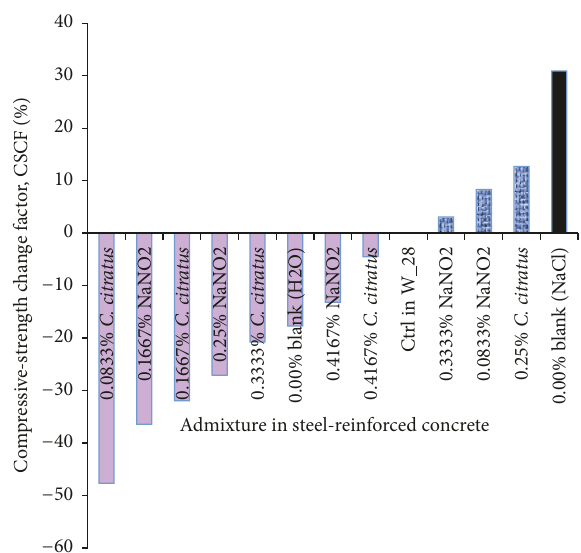
Figure 4: Ranking of compressive-strength change behaviour of studied